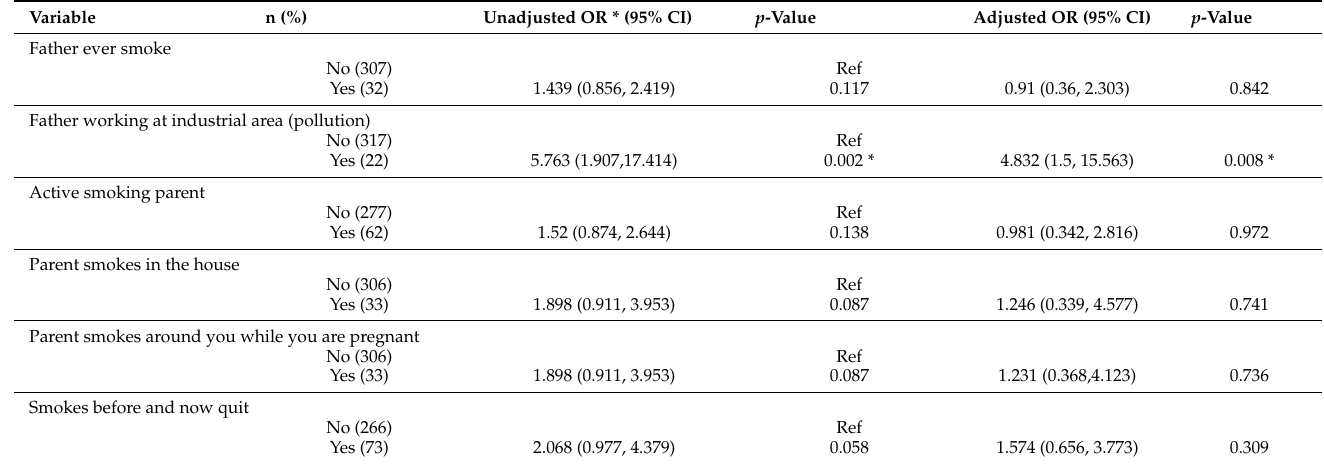
Table 3. Smoking habits as predictors of psychosocial skills of offspring.